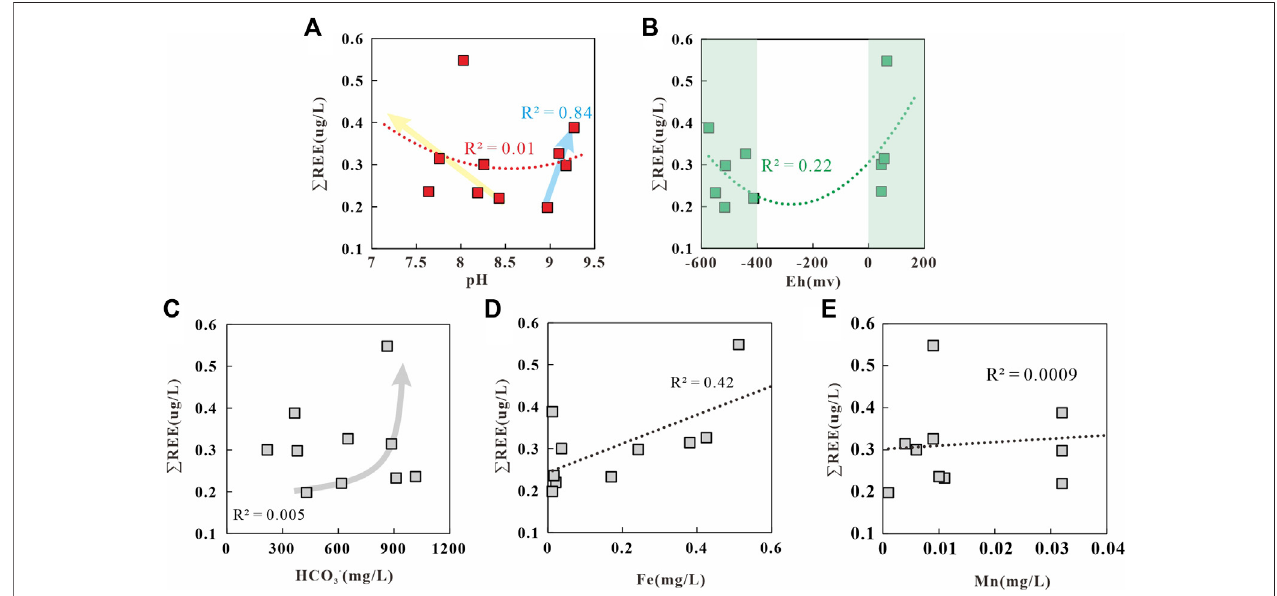
FIGURE 7 | Relationship between (cid:3) REE and pH (A) , Eh (B) , HCO 3 − (C) , Fe (D) and Mn (E) in the geothermal water of Chaluo.